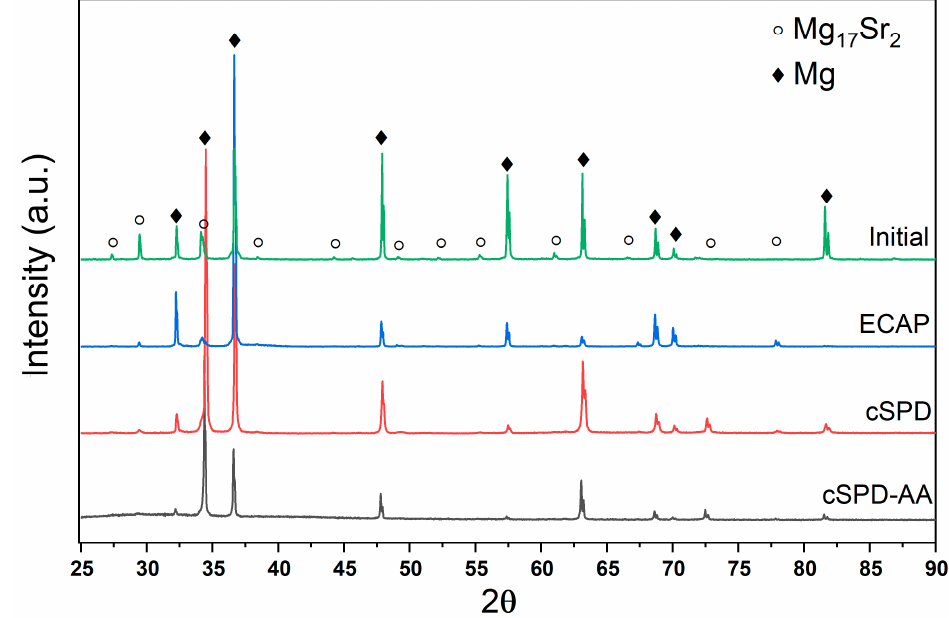
Figure 4. X-ray diffraction patterns of the Mg-2Sr alloy in different structural states. Table 1. The microstructure parameters calculated through the XRD analysis: the lattice parameters a and c , coherent domain size D , density of a -dislocations ρ , microstrain < ε 2 > 1/2 and grain size d cal- culated from TEM images for the Mg-2Sr in different structural states.